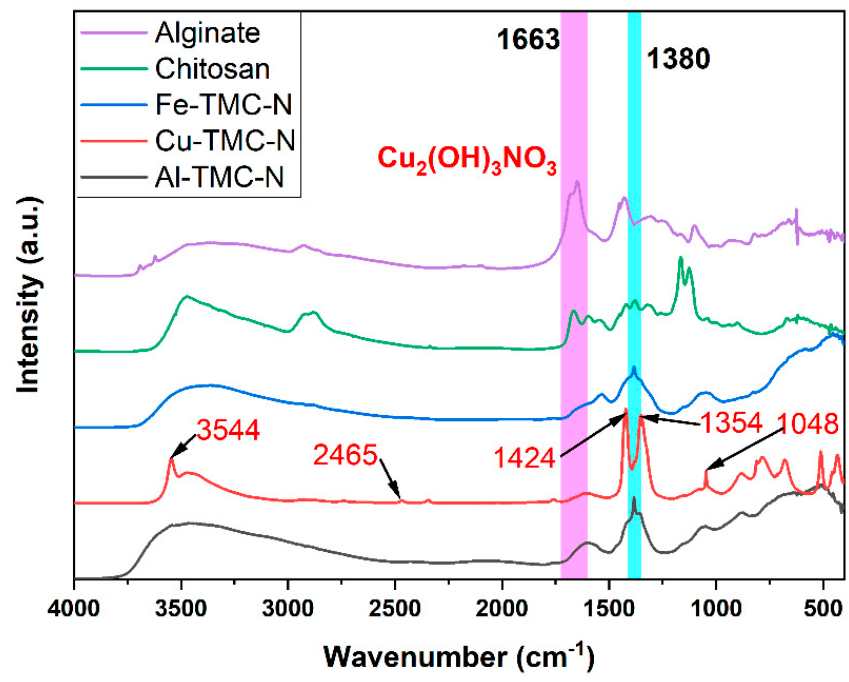
Figure 2. FT-IR spectra of Al-TMC-N, Cu-TMC-N and Fe-TMC-N with highlighted Cu 2 (OH) 3 NO 3 Figure 2. FT ‐ IR spectra of Al ‐ TMC ‐ N, Cu ‐ TMC ‐ N and Fe ‐ TMC ‐ N with highlighted Cu 2 (OH) 3 NO 3 bands in the Cu-TMC-N bands in the Cu ‐ TMC ‐ N spectrum.